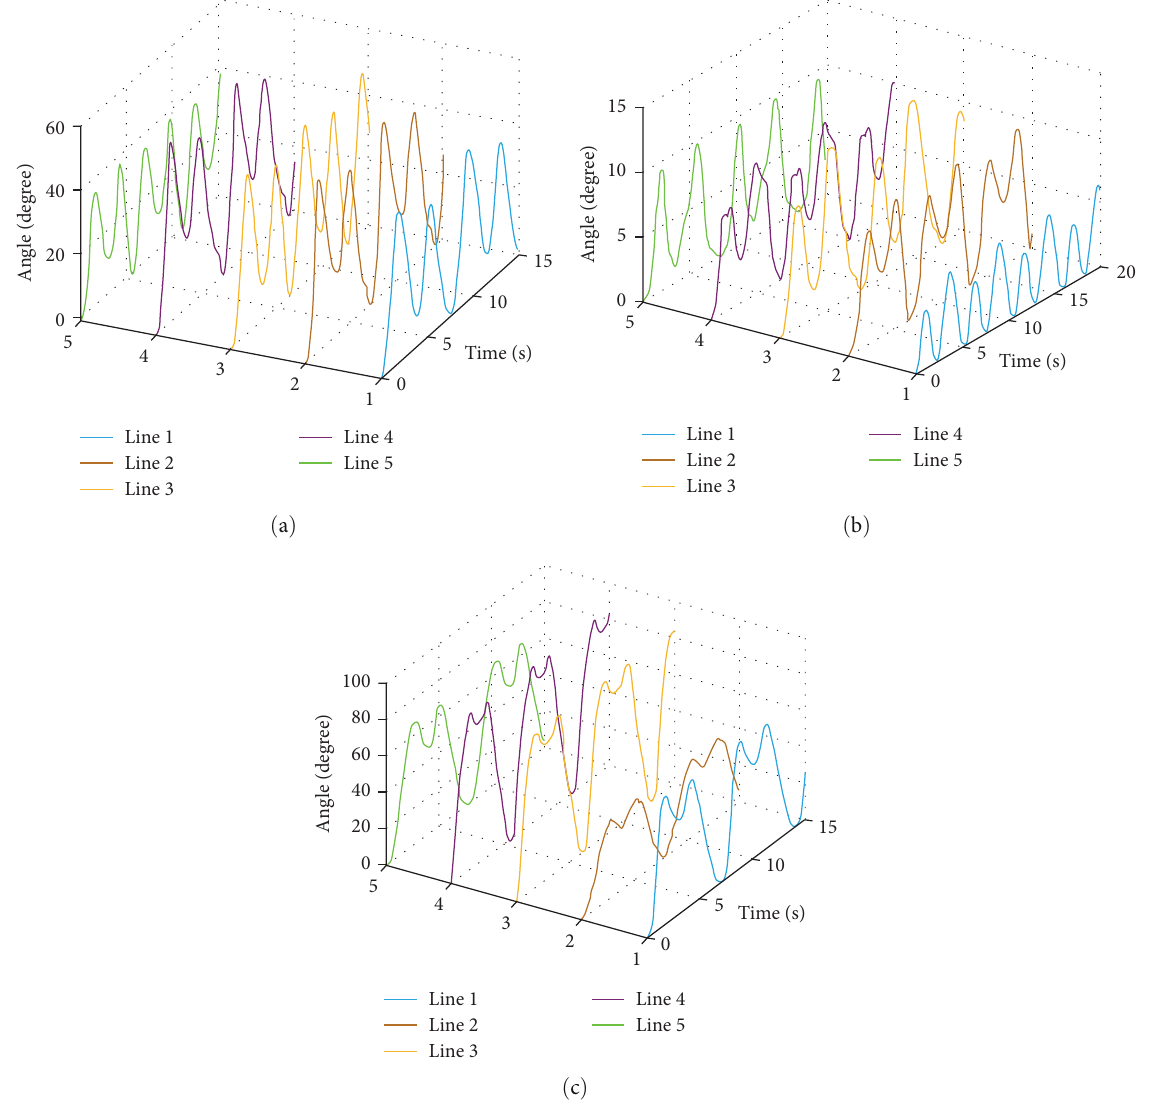
F IGURE 3: PMS of forearm and wrist joint. (a) F/E. (b) R/U deviation. (c) S/P.